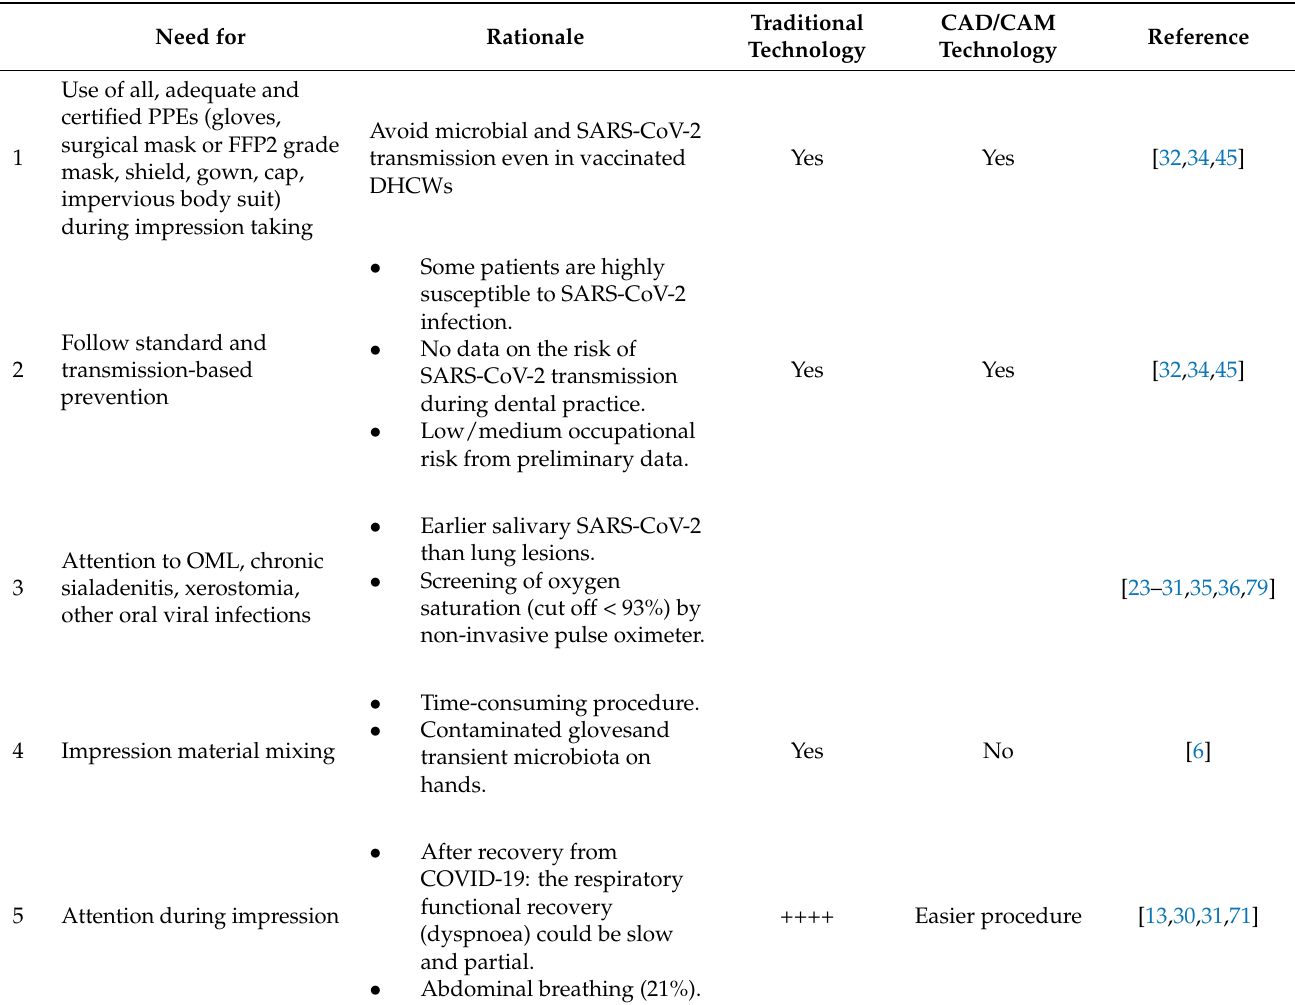
Table 1. Update of the main differences in cross-infection prevention in the case of traditional technology vs. CAD/CAM technology in dentistry during COVID-19 pandemic [6]. Need for Rationale